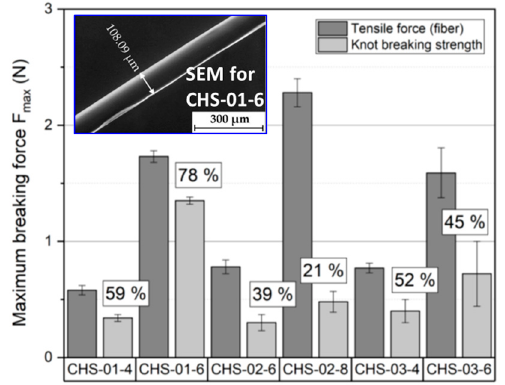
Figure 8. Textile physical tests of chitosan-based fibers, comparing the maximum tensile force and maximum knot breaking strength after a knot formation for the fibers from chitosan and ionic liquid 1-butyl-3-methylimidazolium acetate; the figure was taken and combined from a previously reported work [127].